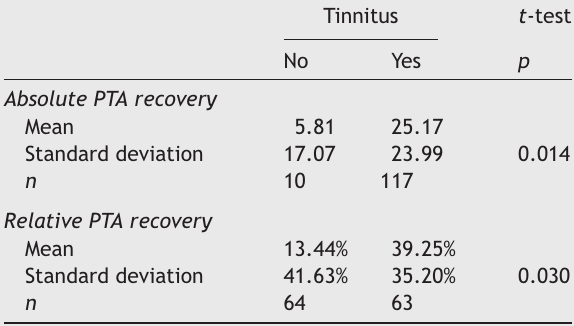
Independent Student’s t -tests between presence and absence of tinnitus for recovery rates.